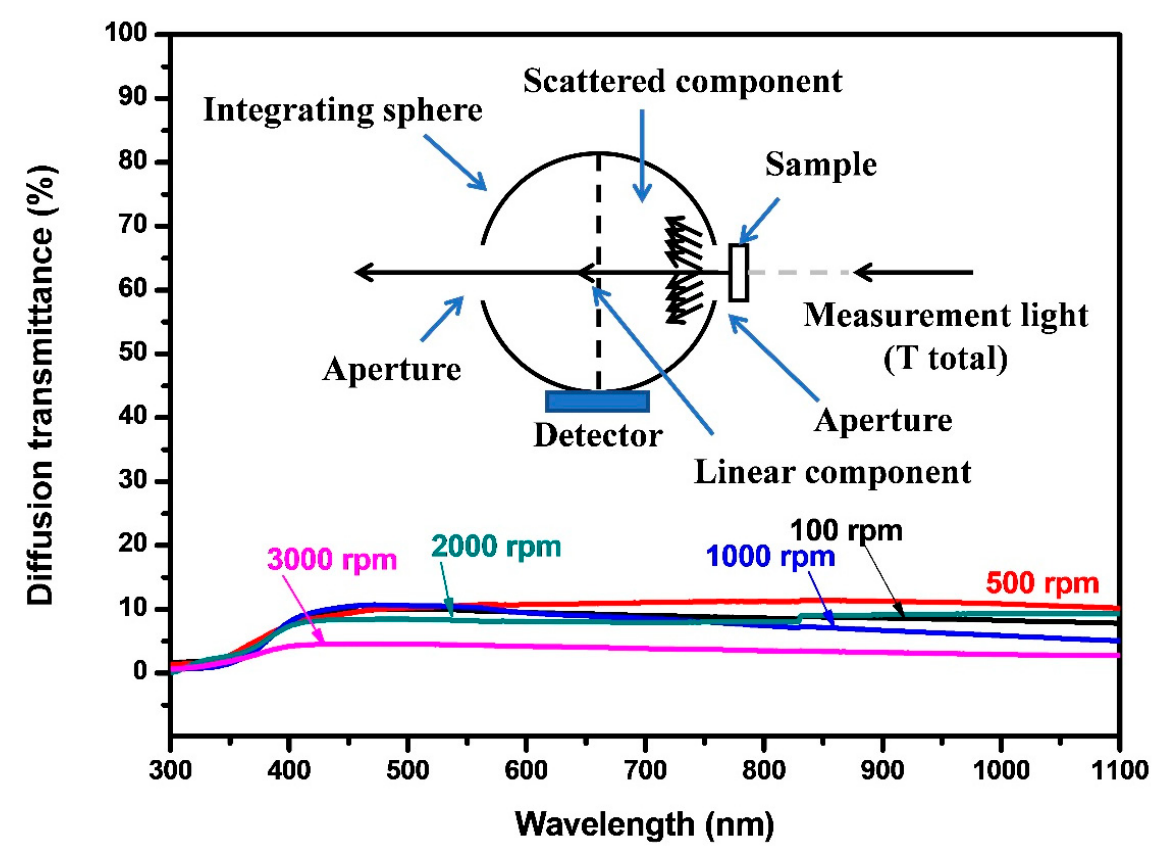
Figure 9. UV-Visible diffusion transmittance spectra of CuCrO 2 thin films prepared at different rotating speeds from 100 to 3000 rpm and annealed at 600 °C. Table 1. UV-Visible transmittance haze of CuCrO 2 thin films annealed in vacuum at 600 ◦ C for 10 min in different rotating speed from 100 to 3000